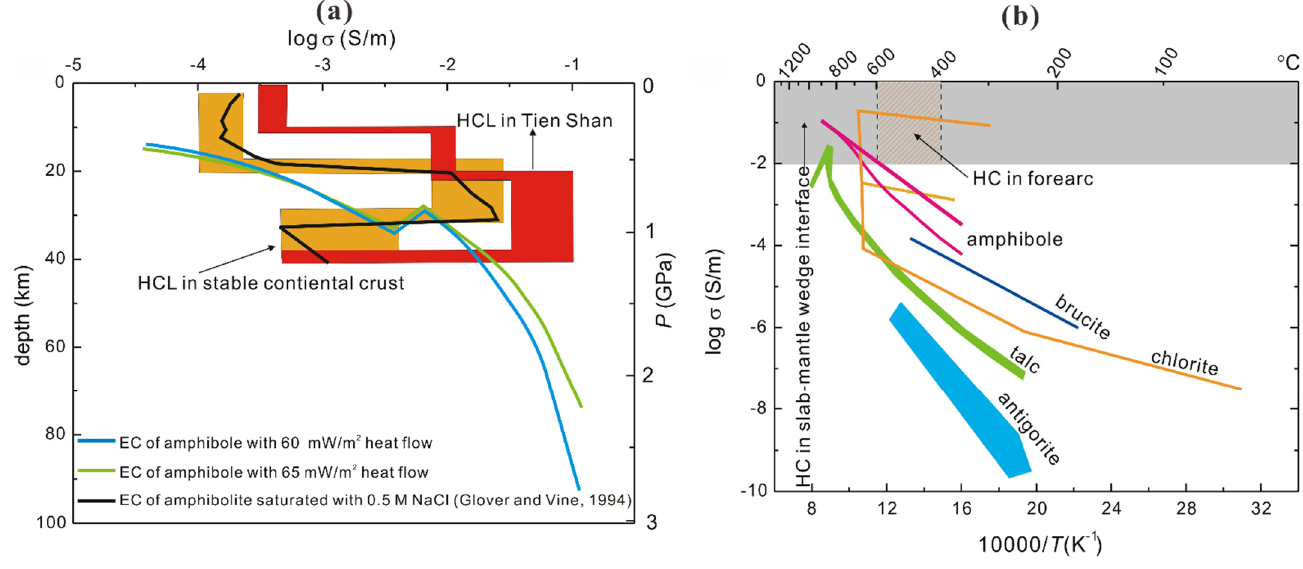
Figure 9. The electrical conductivity–depth profile according to these presently obtained electrical conductivity results on the Fe-bearing hydrous amphibole within the depth ranges from 20 to 40 km ( a ), and at the same time, several electrical conductivity results of some dominant hydrous minerals (e.g., NaCl-bearing saturated amphibole, antigorite, talc, brucite, and chlorite) in the subduction zone are also comprehensively compared ( b ). Data resource: the electrical conductivity of saturated amphibole with 0.5 sodium chloride from Glover and Vine (1994) [118], antigorite from Reynard et al. (2011) [121]; talc from Wang and Karato (2013) [122]; brucite from Guo and Yoshino (2014) [123], and chlorite from Manthilake et al. (2016) [101] (reproduced with permission from the reference of Hu et al. [34]; published by Elsevier, 2018).